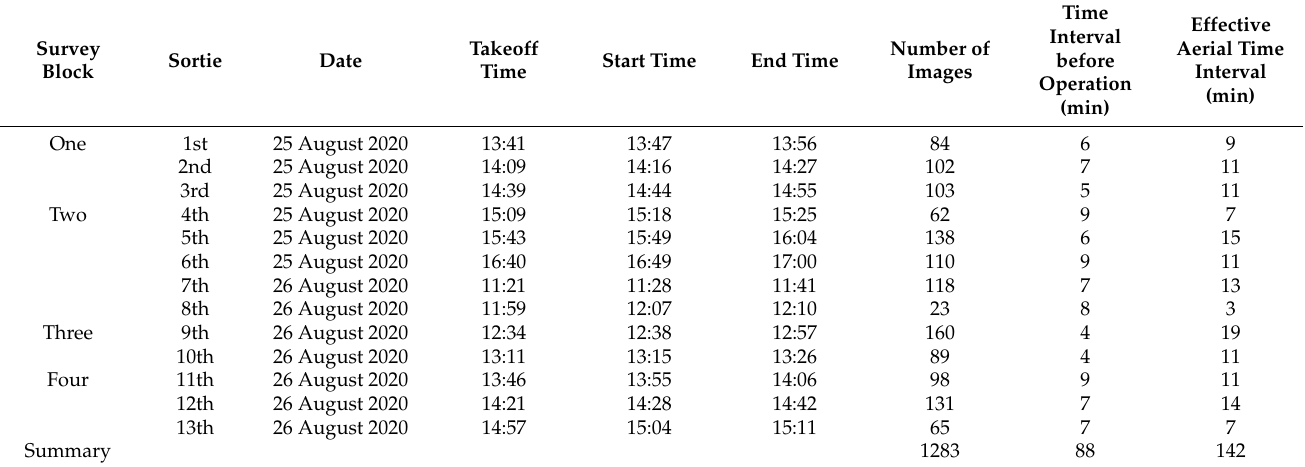
Table 1. Detailed information on aerial photographs taken by drones in the survey